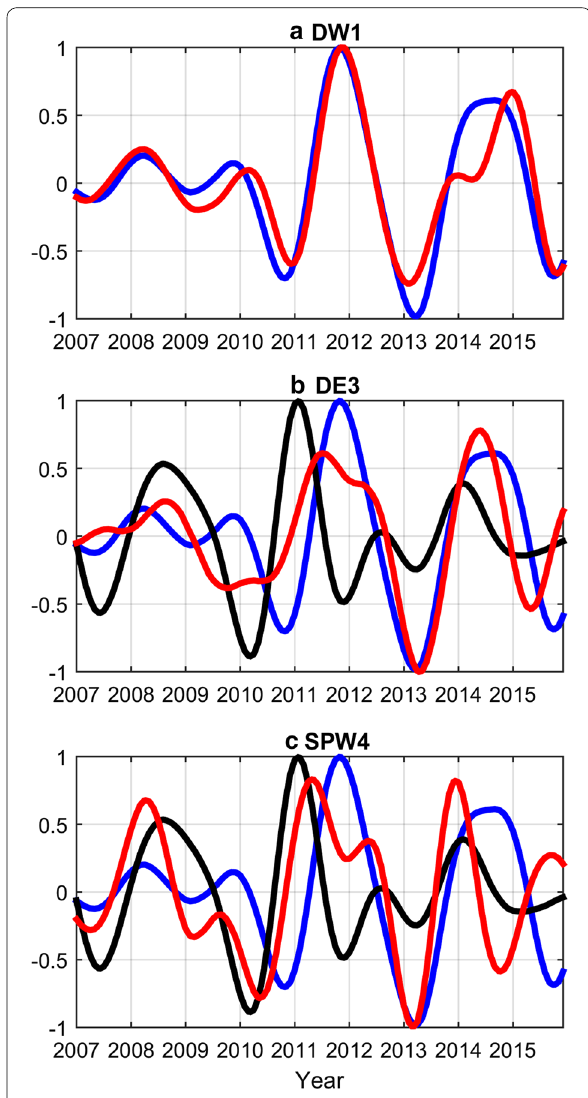
Fig. 5 Comparison of the quasi‑biennial oscillation (QBO) components of the amplitude anomalies of the TEC tidal/SPW (red curve) and zonal wind DE3 (black curve) in lower thermosphere, as well as the F10.7 index (blue curve). A band‑pass filter with the cutoff period ranging from 18 to 34 months is applied to extract the QBO component from the time series. The QBO components have been normalized within 1 for the ±